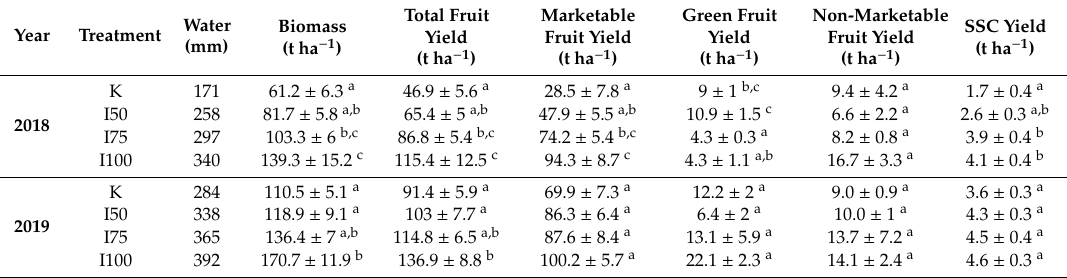
Table 4. Tomato production data for the two experimental years (Means ± Standard errors). “Water” column includes the summarized rainfall and irrigation water in the growing season in the treatments.